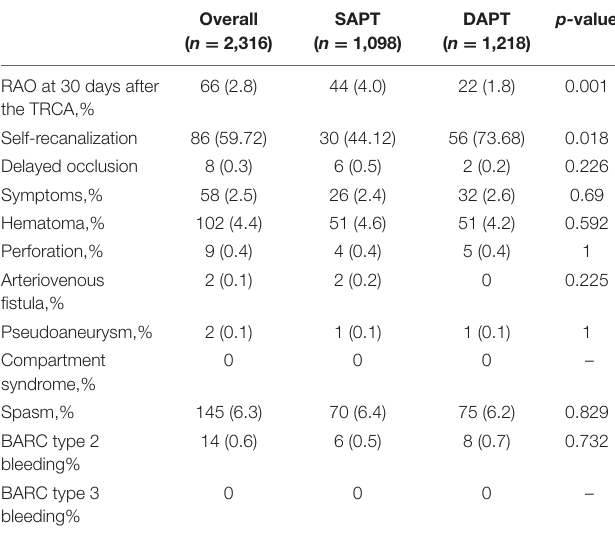
strategy was an independent risk factor for RAO (OR = 0.41, 95% CI = 0.24–0.70, p = 0.001). Other risk factors included SBP, ID of the radial artery, hemostasis time,